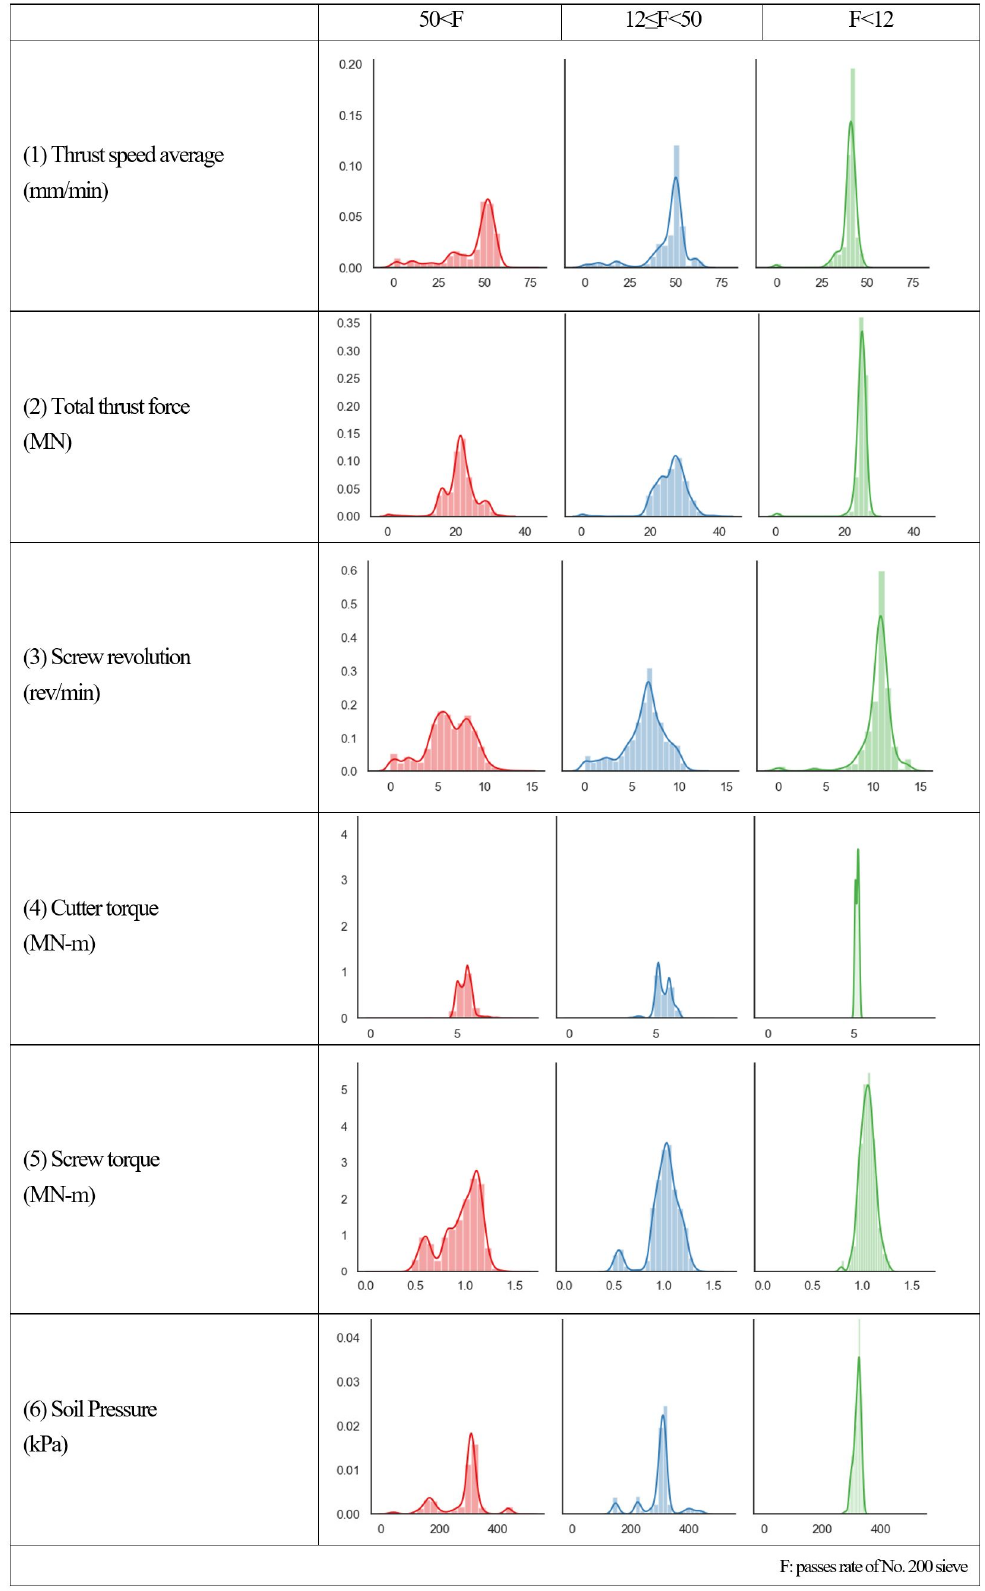
Figure 4. Distribution of data according to ground conditions for data features.